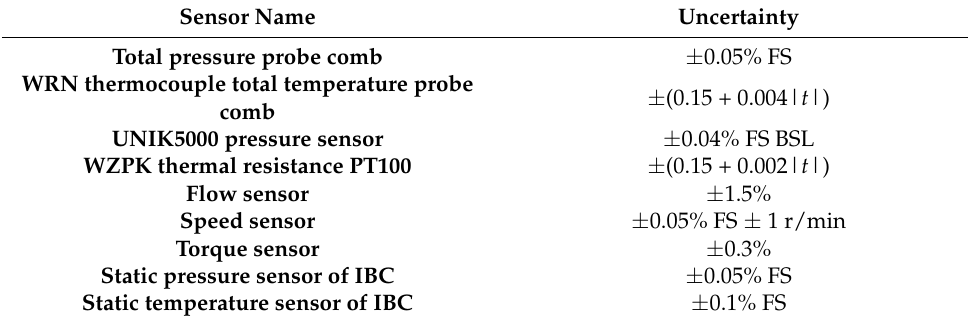
Figure 2. Measuring points and measurement sites of IBC. Table 2. Uncertainties of some major